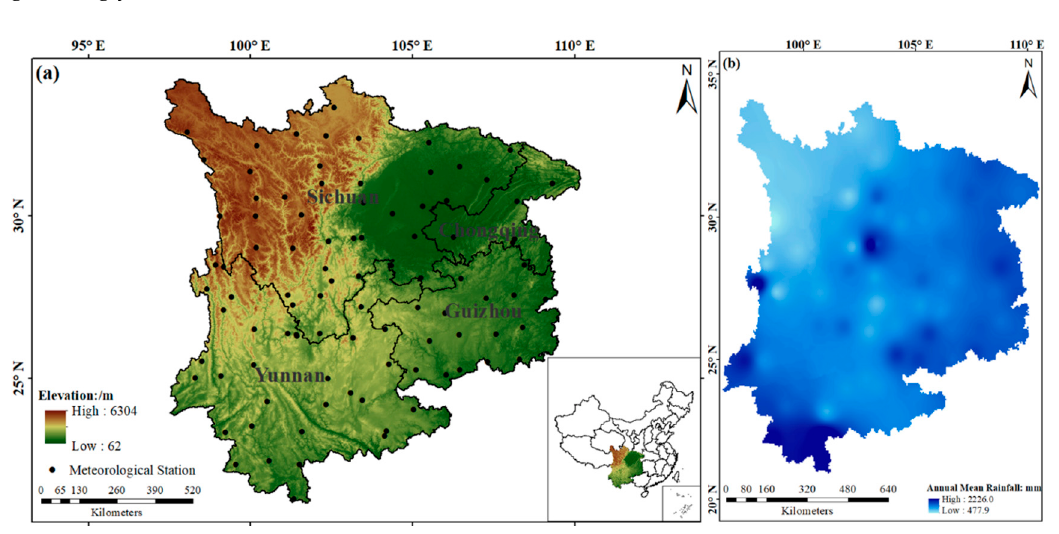
Figure 1. ( a ) Extent of the study area and the location of rain-gauge stations in Southwest China; ( b ) Spatial pattern of annual mean rainfall over Southwest China.